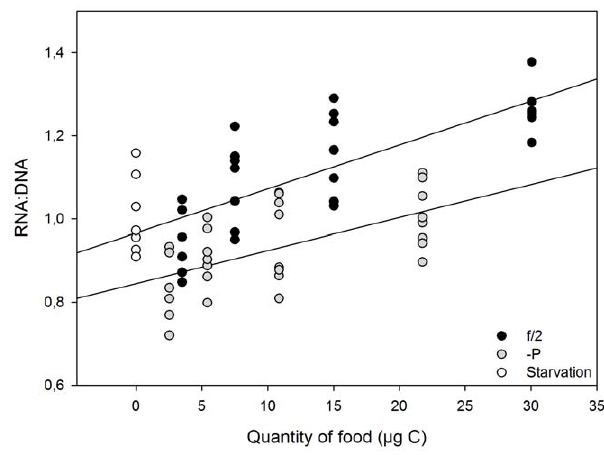
Figure 2. RNA:DNA ratio of the lobster larvae and food quantity expressed as the amount of carbon in the diet.